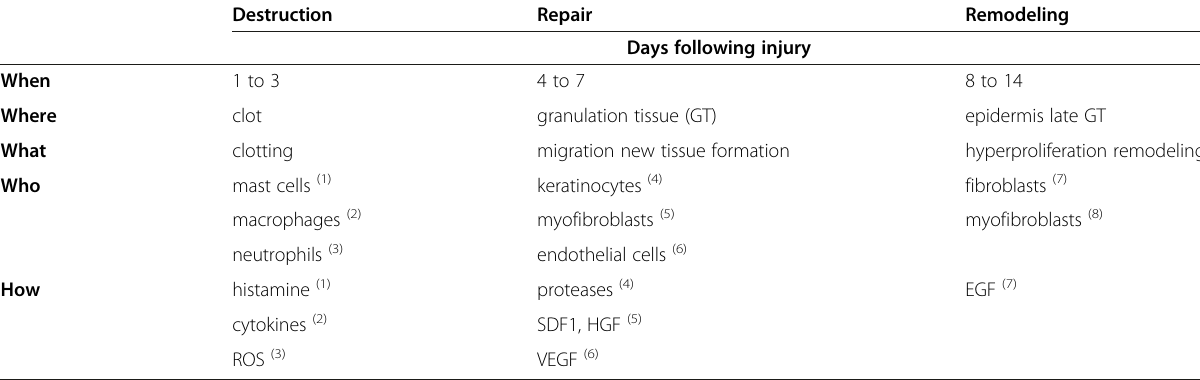
Table 1 Kinetics of wound healing of the epidermis: main phases and players